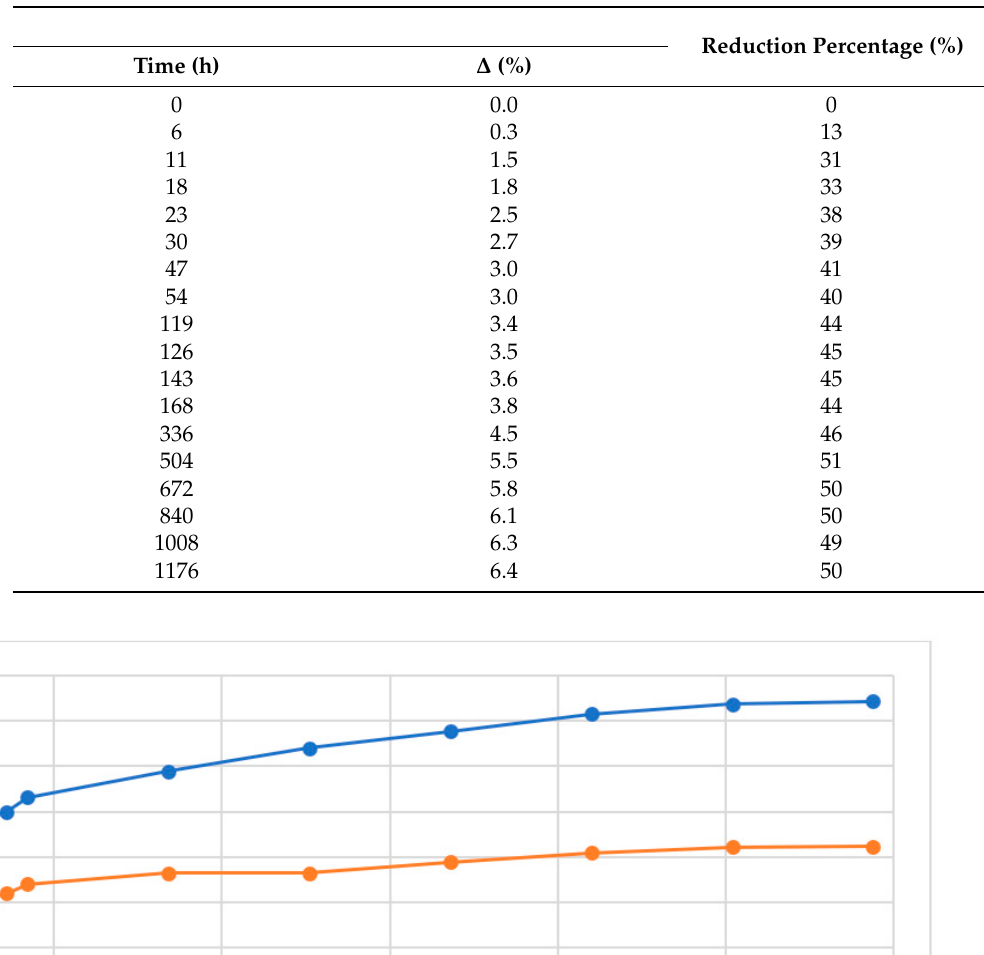
Table 2. Wood moisture content difference between untreated and heat-treated over time and related reduction percentage.